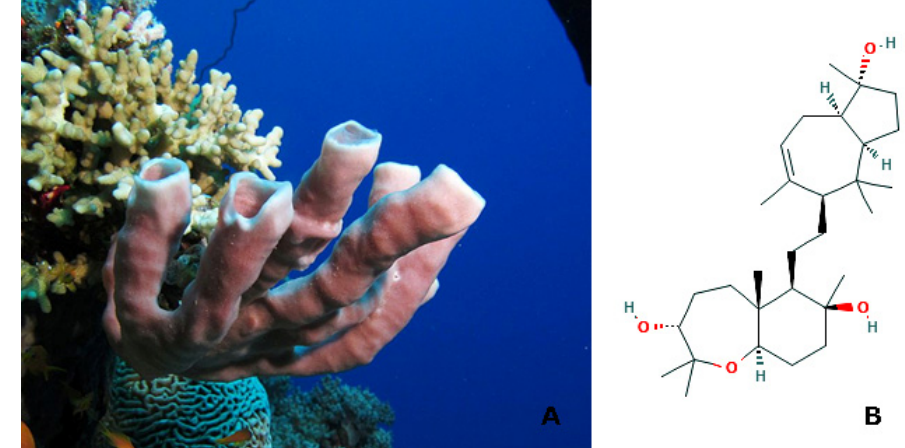
Figure 6. ( A ) A specimen of Siphonocalina siphonella demosponge © Alexander Vasenin (CC BY-SA 3.0); https: // commons.wikimedia.org / . ( B ) 2D structure of sipholenol A; https: // pubchem.ncbi.nlm.nih.gov /